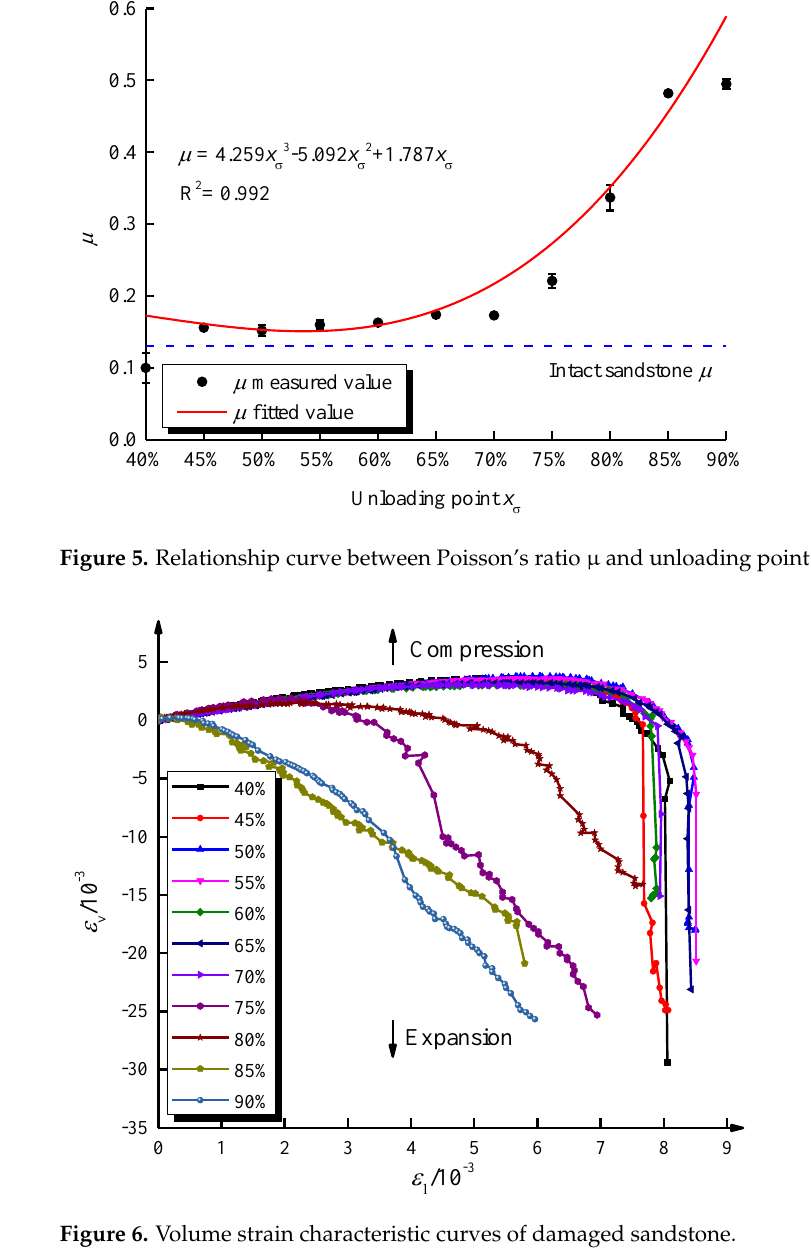
Figure 6. Volume strain characteristic curves of damaged sandstone.